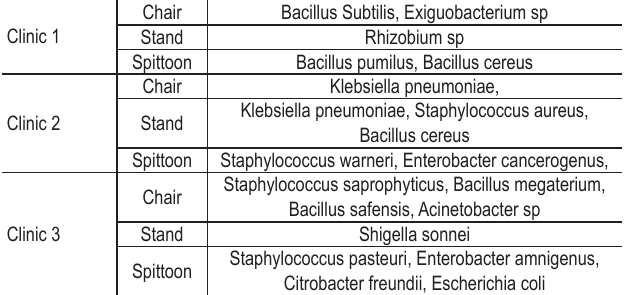
Table 1 - Correlation between clinics, places and species / bacterial genus found.